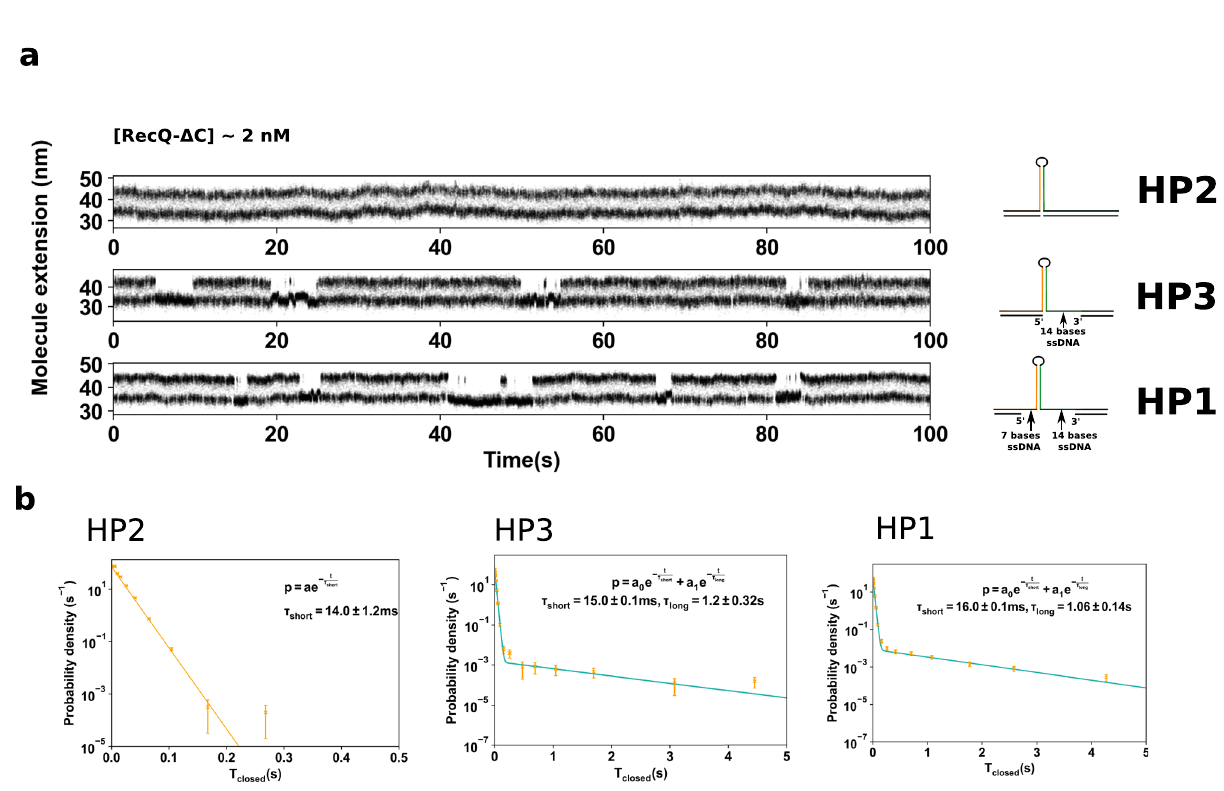
Fig. 4 Stabilization of a fraying DNA fork by RecQ- Δ C as a function of the con fi guration of the nascent strands. a Time-course experiments showing the extension changes of the fl uctuating probe in presence of RecQ- Δ C at 2 ± 1 nM for different probes (right) whose sequence can be found in Table S2. The stabilization of the closed state only happens when there is a single-stranded gap on the leading strand (HP1 and HP3), and is happening regardless of the presence of a single-stranded gap on the lagging strand (HP1). b Distributions of the time spent in the closed states for the three hairpins.